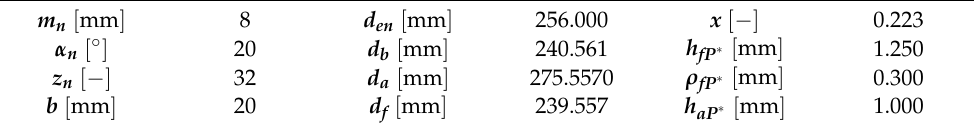
Table 4. Gear data relative to the 8 mm-module